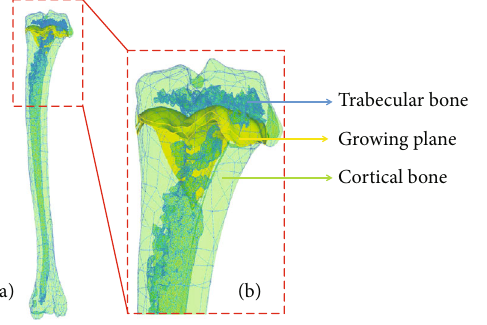
Figure 5: Geometry of the tibia: (a) the whole tibia model and (b) the proximal tibia.